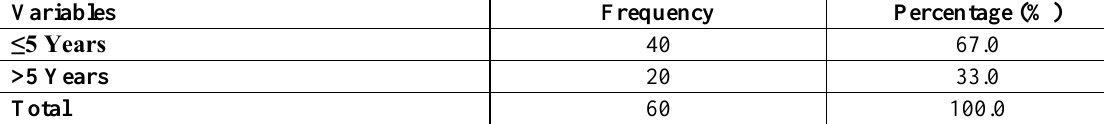
Table 1. Distribution of study group according to Experience (years).